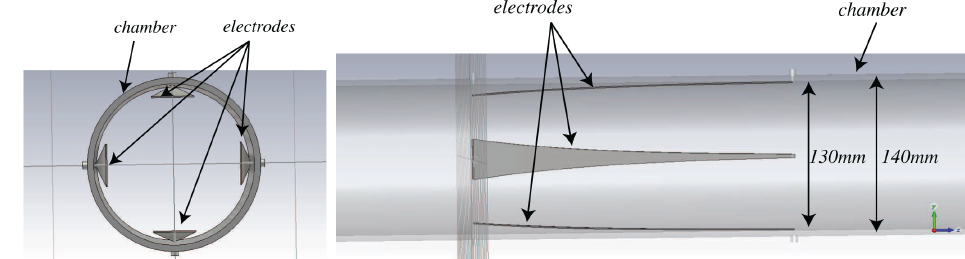
FIG. 2. The simulation model for a chamber housing the exponential electrodes. Front view (left) and side view (right).